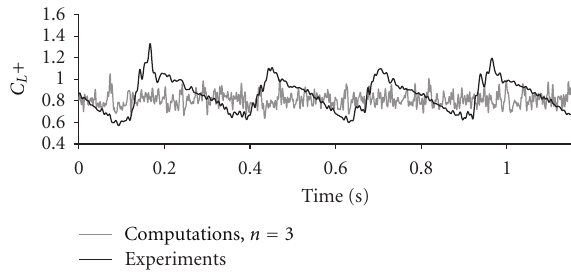
Figure 14: Comparisons of the measured and the predicted suction side lift coe ffi cients obtained using the Singhal cavitation model with n = 3. σ = 1, Re = 750,000, V ∞ = 5 m/s, and α = 6 ◦